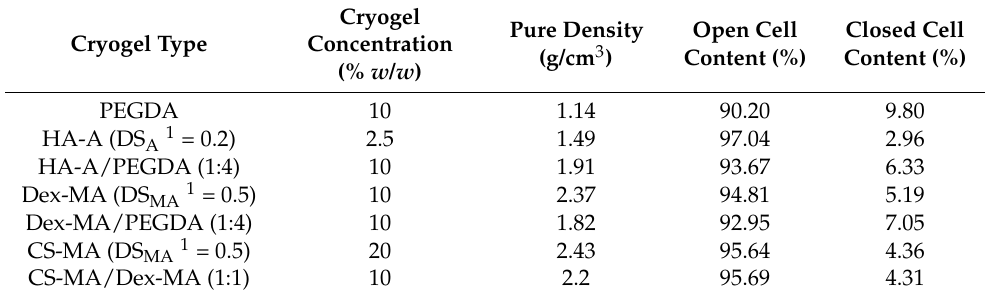
Table 4. Comparison of pure density and open and closed cell content of different types of